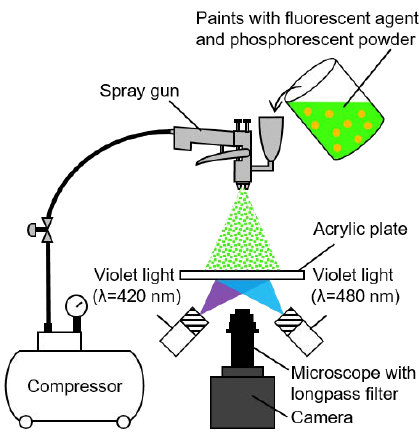
Microscope with longpass filter Figure 1. Experimental